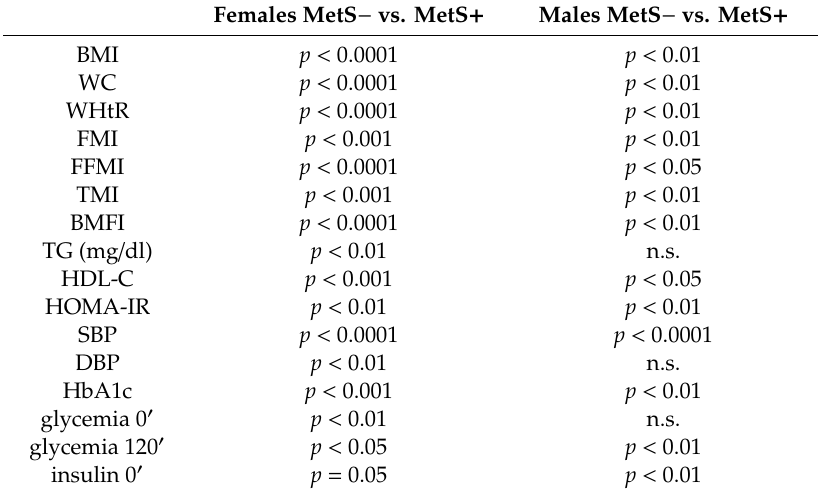
Table 3. Comparison of all parameters recorded in patients with and without MetS (MetS + vs. MetS − ) in the two genders.